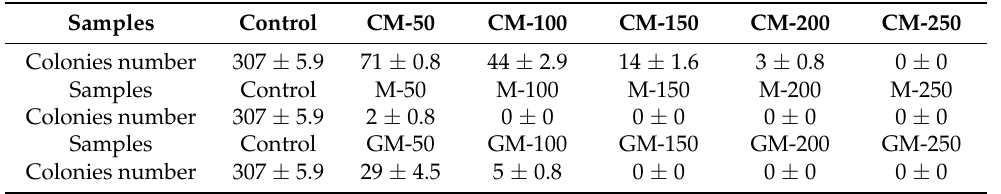
Table 6. The E. coli colony numbers of the fabrics on the agar plates.